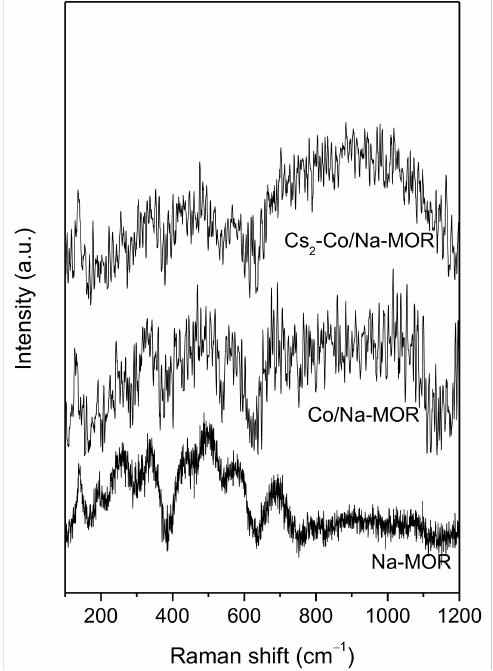
Figure 5. Laser Raman Spectroscopy (LRS) spectra of Na-MOR, Co/Na-MOR, and Cs 2 -Co/Na-MOR powders.